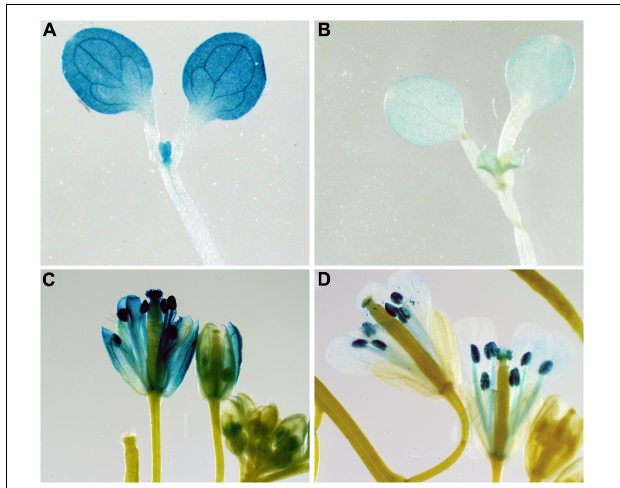
FIGURE 5 | Expression patterns of BrPYP in Arabidopsis . BrPYP promoter-GUS expression of the yellow (A) and pale-yellow (B) type in Arabidopsis leaves. BrPYP promoter-GUS expression of yellow (C) and pale-yellow (D) type in Arabidopsis flowers.